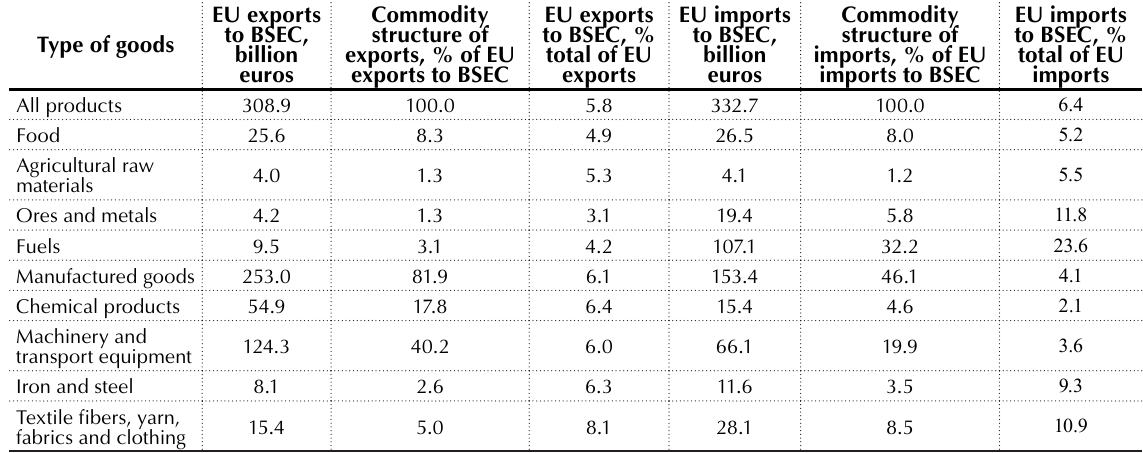
Source: UNCTAD and authors’